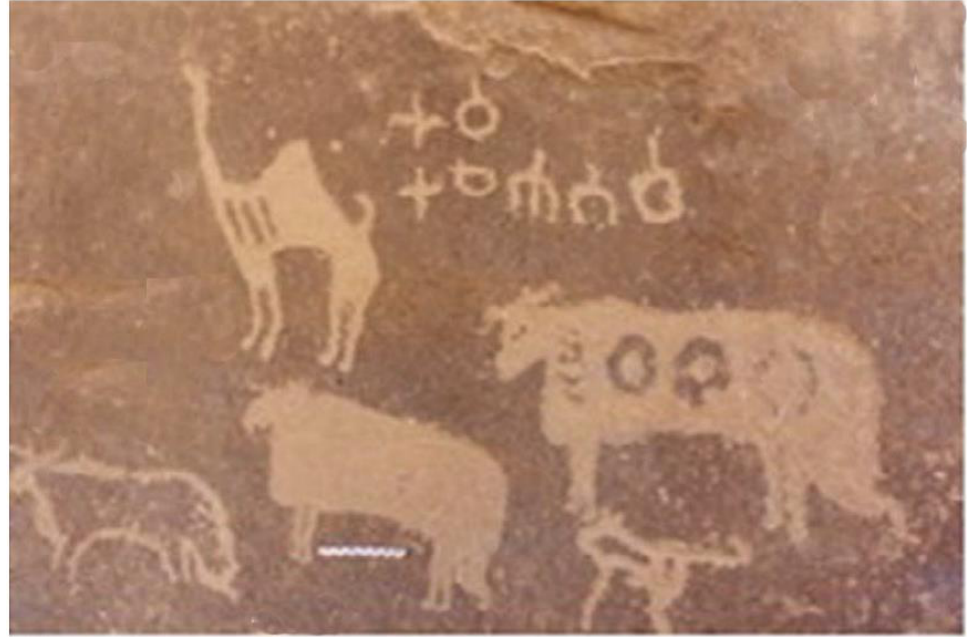
Figure 11. Camel and sheep with Wasum , or tribal symbols, marked on their